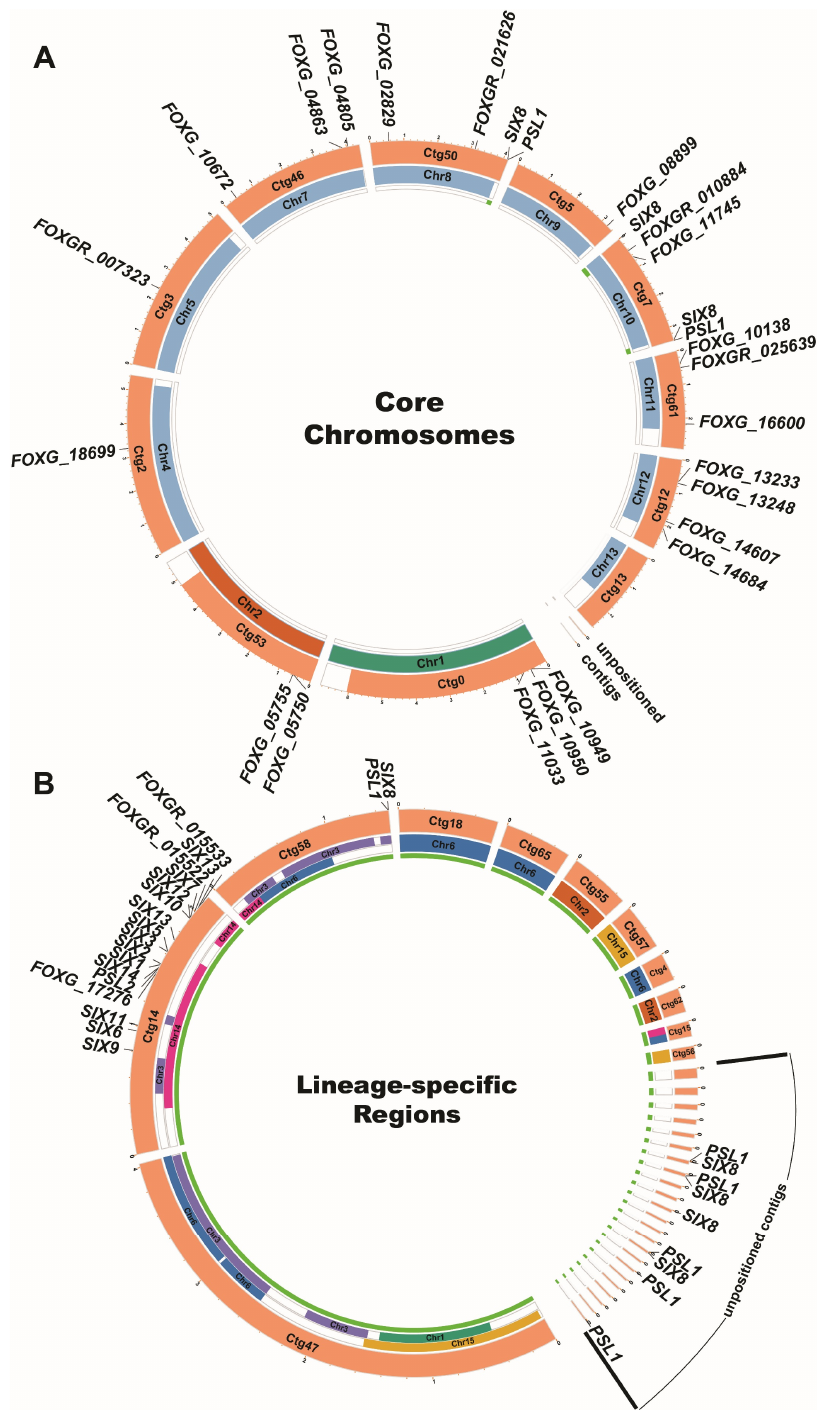
Figure 2. Distribution of the 55 Fol effector candidate genes on the physical map of the Fol4287 genome. Circos plots showing the distributions of Fol effector candidate genes on the core chromo- somes ( A ) and the lineage-specific (LS) regions ( B ). In both Circos plots, the orange segments in the outer circle represent the contigs assembled following the PacBio sequencing of the Fol4287 genome. The colored segments in the middle circle represent the corresponding chromosomes assembled following Sanger sequencing of the Fol4287 genome. The various colors have been used to highlight the extensive rearrangement of the LS chromosomes and LS regions in the new PacBio assembly compared to the old assembly. The thin green segments on the inner circle represent the LS regions in the Fol4287 genome compared to the Fusarium verticillioides